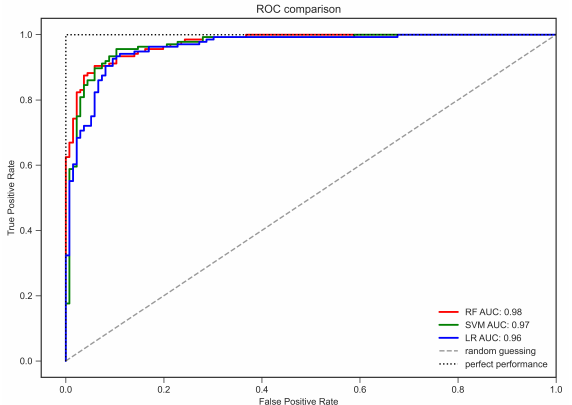
Figure 8. Plot of AUC–ROC curves for the ML model with Predictor Set I—without climate variables.